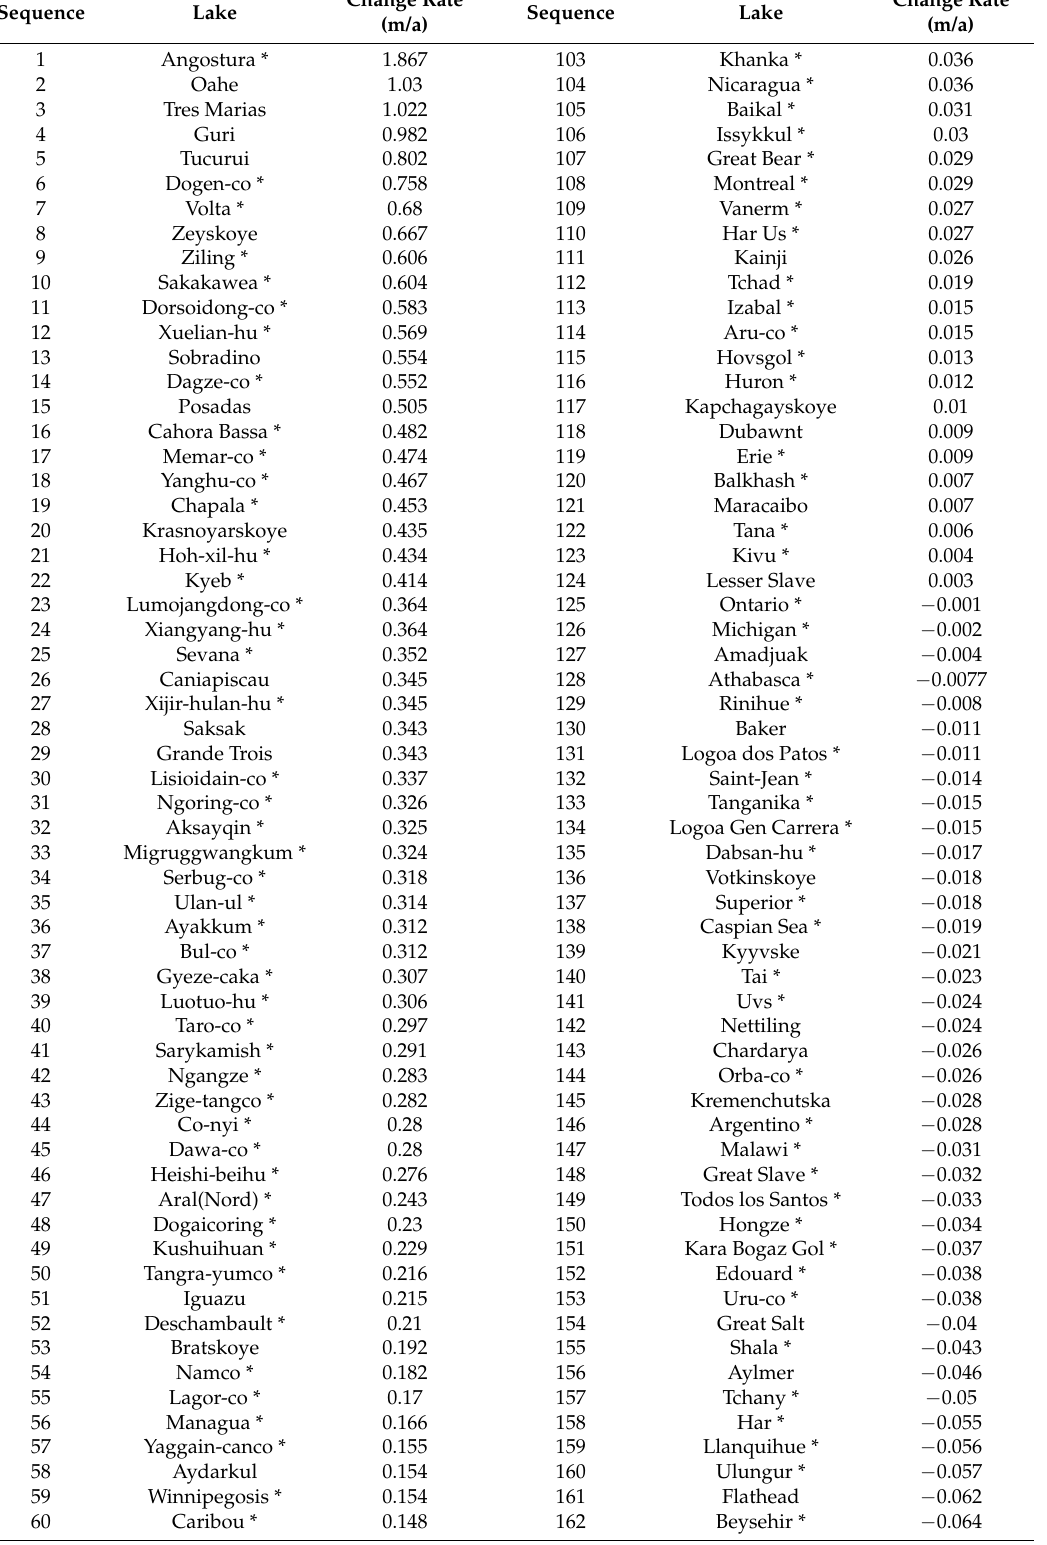
Table A1. The change rates of the lake levels in